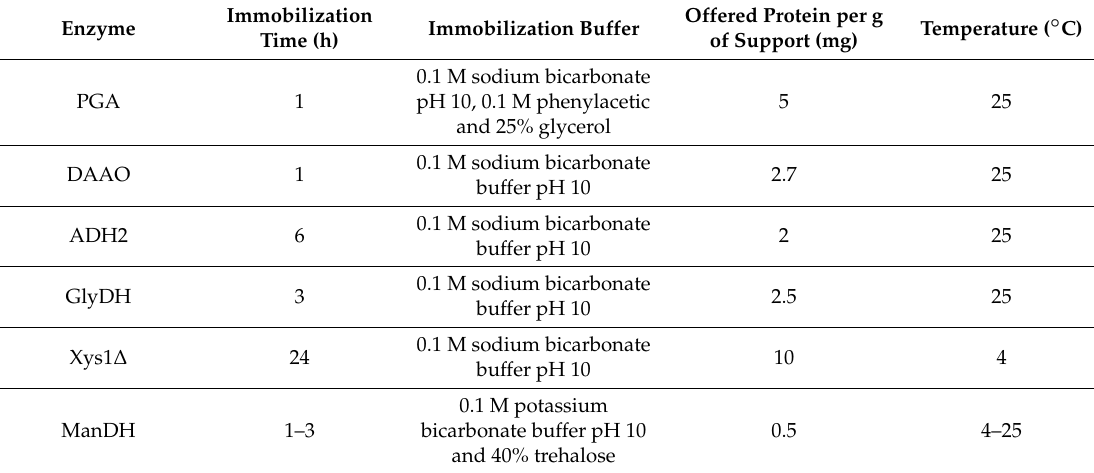
Table 5. Protein immobilization conditions